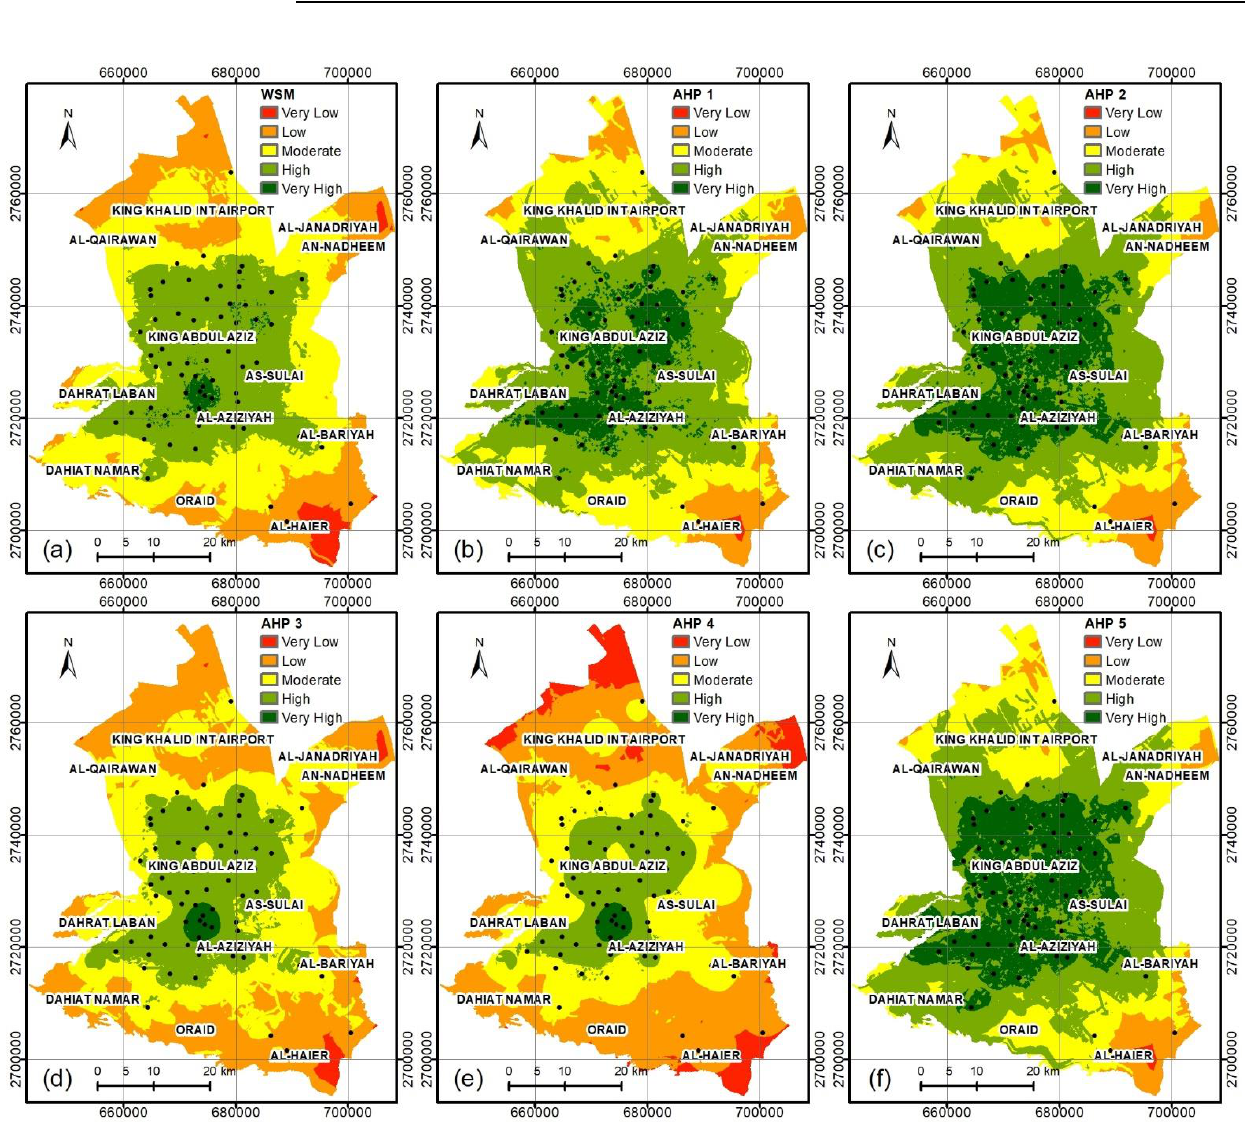
Figure 5. Spatial distribution of the CDCs of the study area using models ( a ) WSM, ( b ) AHP-1, ( c ) AHP-2, ( d ) AHP-3, ( e ) AHP-4, and ( f ) AHP-5.